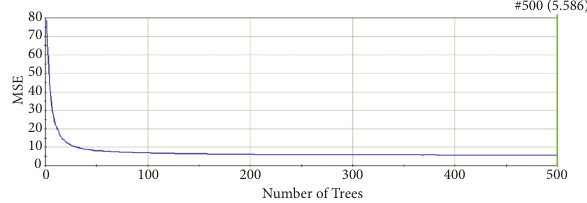
Figure 5: The result of Random Forests. Table 7: Variable importance after filtering feature variables.